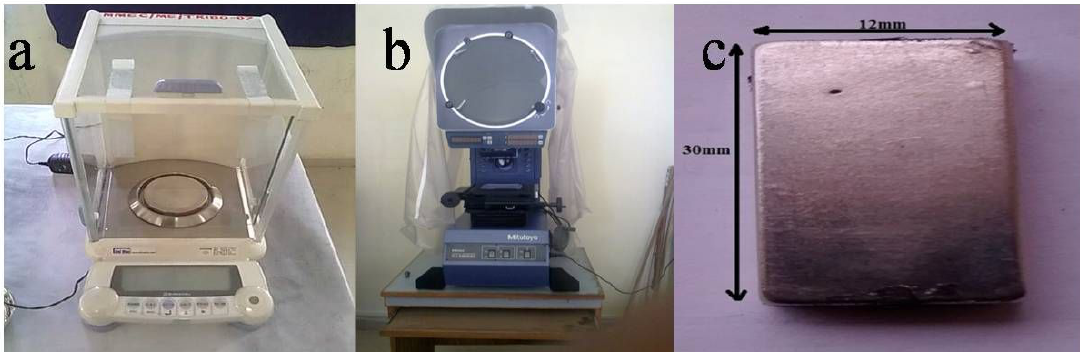
Figure 2: (a) Precision weight balance; (b) Profile projector; (c) Neodymium